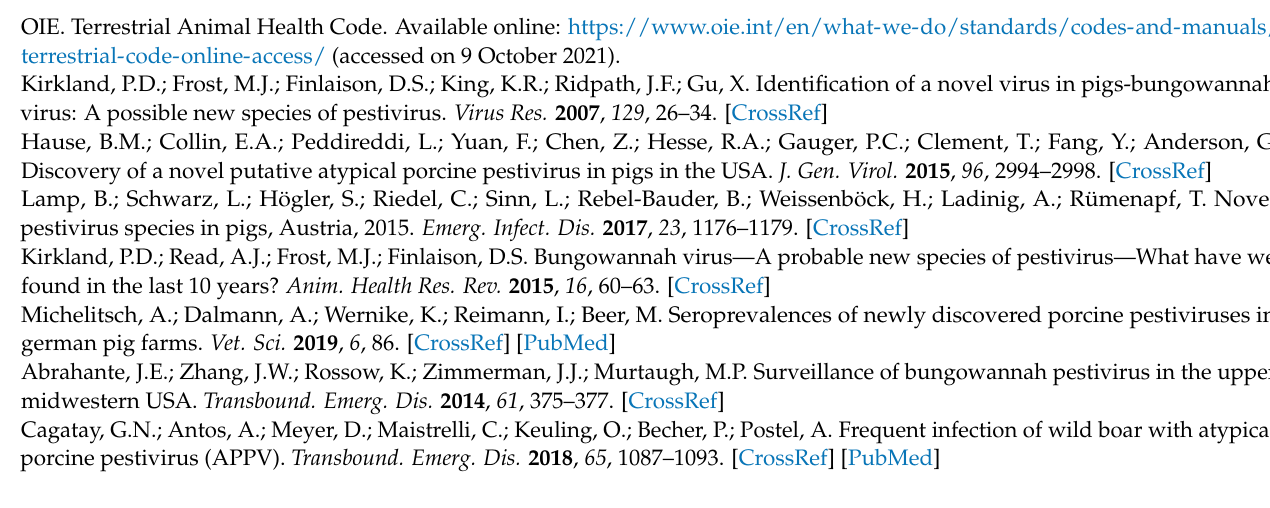
Supplementary Table S1: Results of serum virus neutralization (SVN) assay (1/ND 50 /mL), RT-qPCR assay (GE/mL; GE/g; GE/swab) and virus isolation from six-week-old nursery pigs, Supplementary Table S2: Results of SVN assay (1/ND 50 /mL), RT-qPCR assay (GE/mL, GE/g) and virus isolation from an eight-week-old euthanized nursery pig suffering from a paralysis of both hind